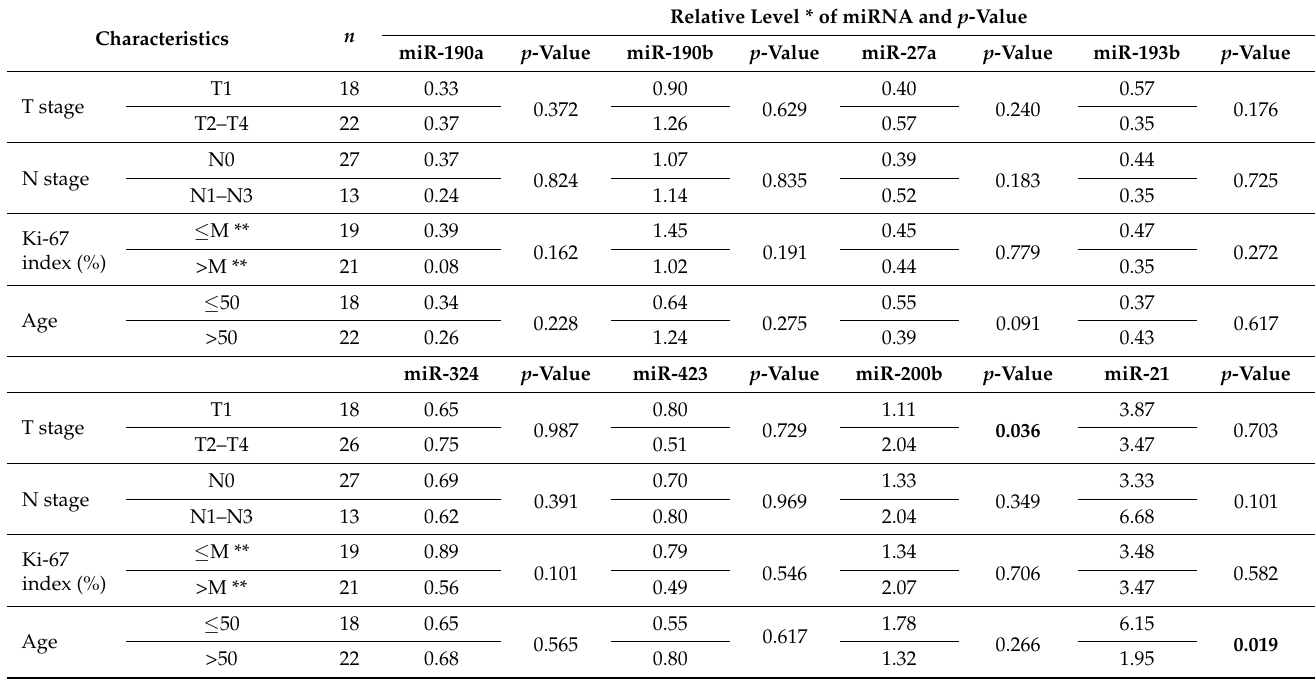
Table 6. Association of miR-190a, miR-190b, miR-27a, miR-193b, miR-324, miR-423, miR-200b, and miR-21 expression with clinicopathologic characteristics of ER- and PR-negative BC.